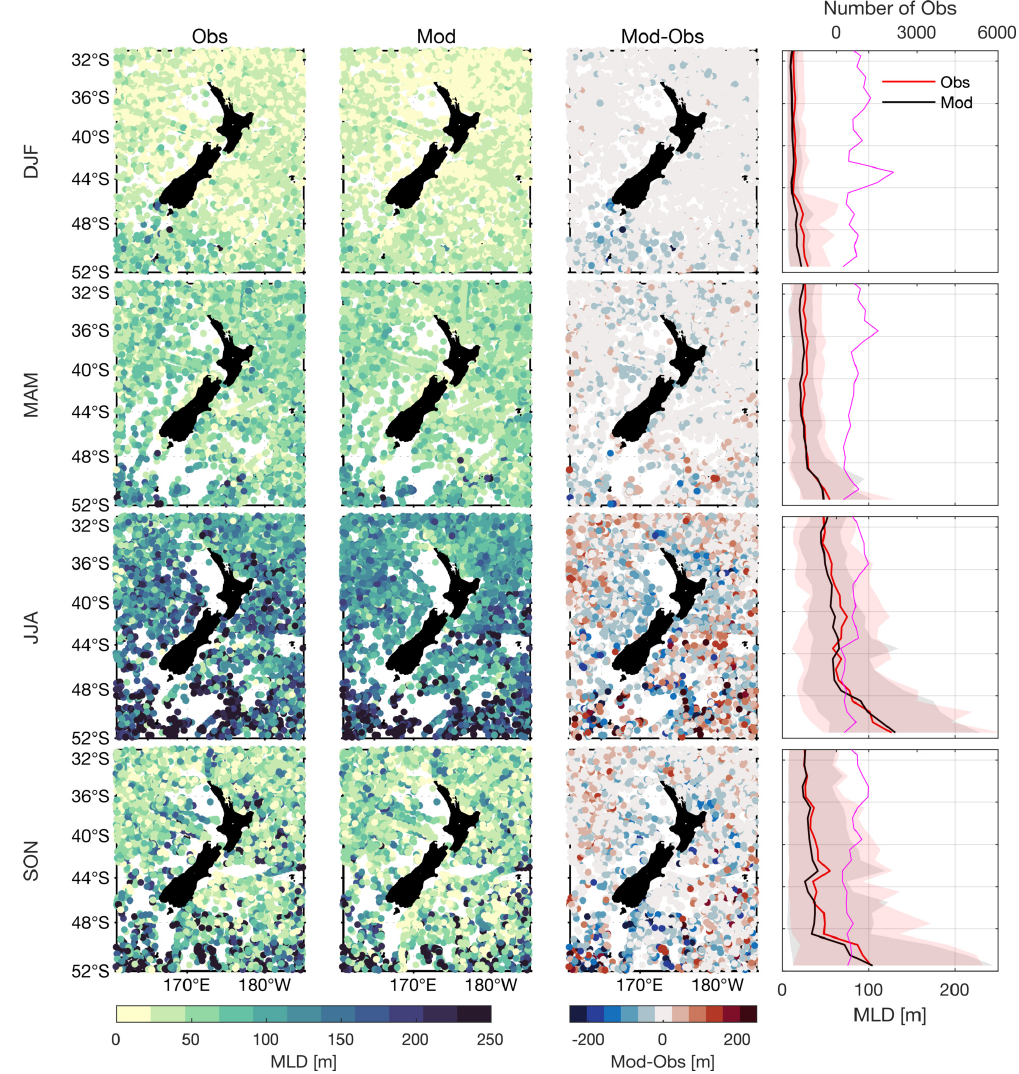
Figure 9. Seasonal mixed-layer depths (MLDs) computed from temperature profiles from CORA5.2 (first column), the Moana Ocean Hind- cast (second column) and the difference between these (third column) within the region 31–52 ◦ S, 161–185 ◦ E over the period 1994–2017 using a temperature threshold method (Holte and Talley, 2009). The last column indicates the zonal-mean MLD from the Moana Ocean Hindcast (black solid) and CORA5.2 (red solid), together with the 5th and 95th percentiles (shaded). Also shown are the number of